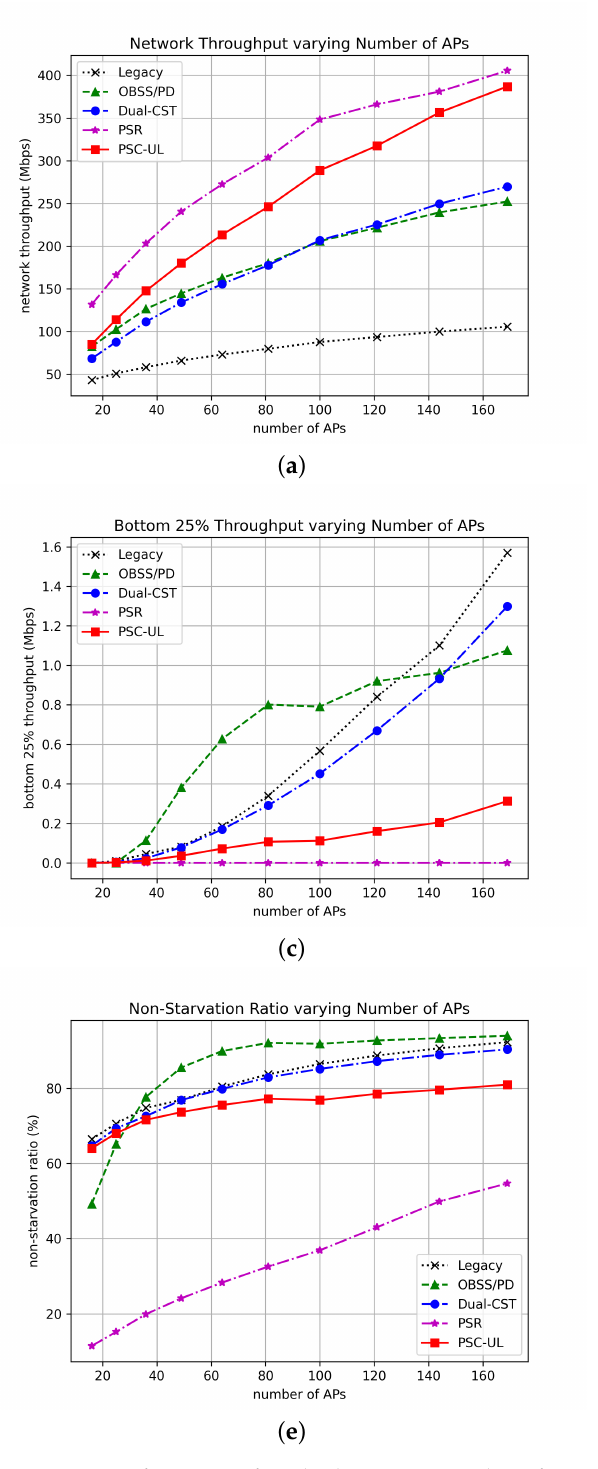
Figure 10. Performance of methods varying number of APs. ( a ) Total throughput; ( b ) Bottom 50% throughput; ( c ) Bottom 25% throughput; ( d ) Fairness; ( e ) Non-starvation Ratio; ( f ) Delivery